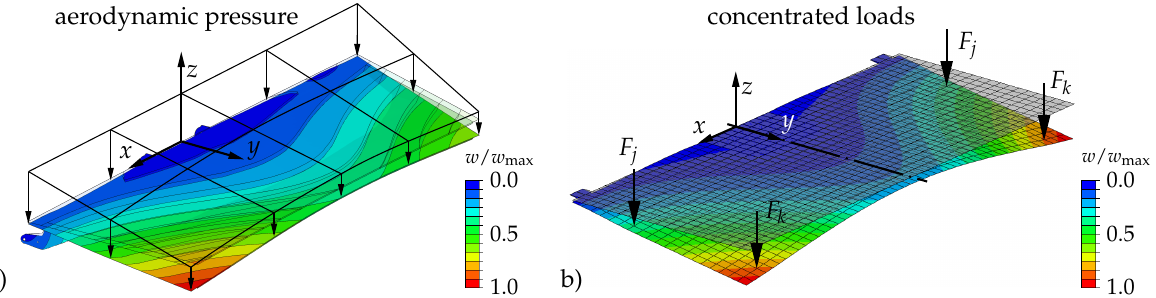
Figure 5. Result of loading optimization on an idealized spoiler demonstrator. Schematic sketch of ( a ) the real aircraft spoiler due to aerodynamic loads and ( b ) the idealized spoiler demonstrator under four-point loading (half model rendered in symmetrical full view for display purposes).